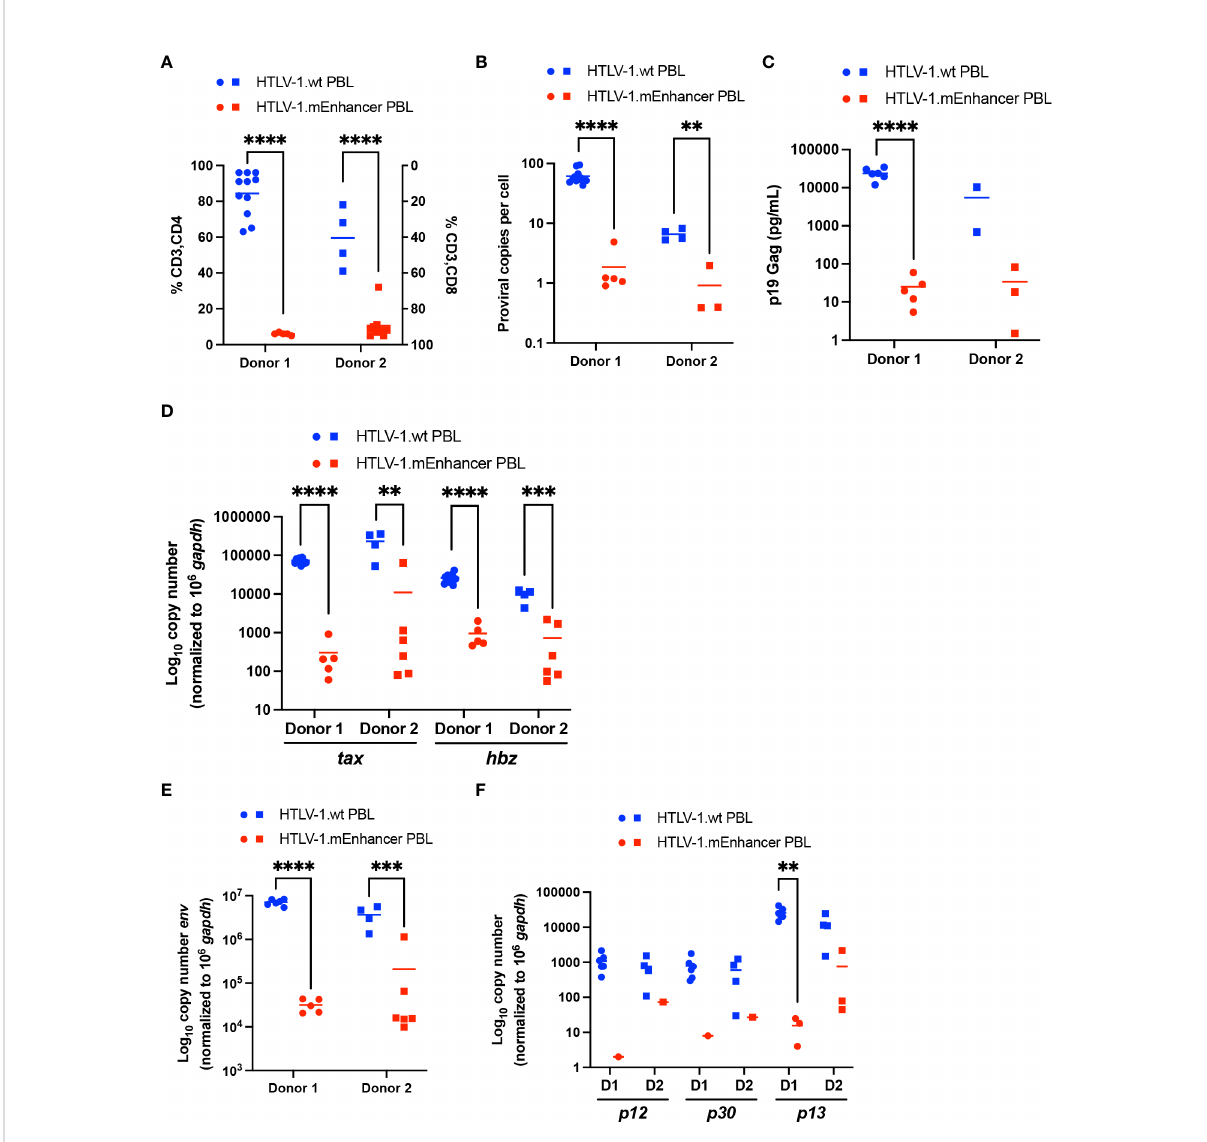
FIGURE 7 Loss of HTLV-1 enhancer element alters immortalization phenotype and viral gene expression in vitro . Newly immortalized PBL cell lines from two separate co-culture experiments with different PBMC donors were characterized in vitro . Cell lines from Donor 1 are represented by circles, and cell lines from Donor 2 are represented by squares. (A) T-cell phenotypic analysis of HTLV-1.wt (Donor 1 n=11; Donor 2 n=4) or HTLV-1.mEnhancer PBLs (Donor 1 n=5; Donor 2 n=9) was performed by fl ow cytometry. (B) Genomic DNA was extracted from PBL cell lines and used for qPCR to detect proviral load using primers targeting HTLV-1 Gag/pol (HTLV-1.wt: Donor 1 n=11, Donor 2 n=4; HTLV-1.mEnhancer: Donor 1 n=5, Donor 2 n=3). (C) Approximately 5 x 10 5 PBLs were plated in 1 mL media. Supernatant was collected from each well after 72h and analyzed by p19 Gag ELISA. (HTLV-1.wt: Donor 1 n=6, Donor 2 n=2; HTLV-1.mEnhancer: Donor 1 n=5, Donor 2 n=3) (D) RNA was extracted from each PBL cell line, and subjected to cDNA synthesis followed by qPCR to detect tax and hbz gene expression. Data are shown normalized to 1 x 10 6 hgapdh copies (HTLV-1.wt: Donor 1 n=11, Donor 2 n=4; HTLV-1.mEnhancer: Donor 1 n=5, Donor 2 n=6) (E, F) PBL RNA was isolated and used for cDNA synthesis. Pre-ampli fi cation was performed, followed by qPCR to determine expression of env , p12 , p30 , and p13 viral transcripts. Data are shown normalized to 1 x 10 6 hgapdh copies. Values of zero for cell lines with undetectable transcripts are not plotted or included in the statistical analyses (HTLV-1.wt: Donor 1 n=6, Donor 2 n=4; HTLV-1.mEnhancer: Donor 1 n=5, Donor 2 n=6). Donor 1 and Donor 2 are abbreviated as D1 and D2, respectively, in (E) . Statistical signi fi cance was determined by unpaired t test. **P ≤ 0.01, ***P ≤ 0.001, ****P ≤